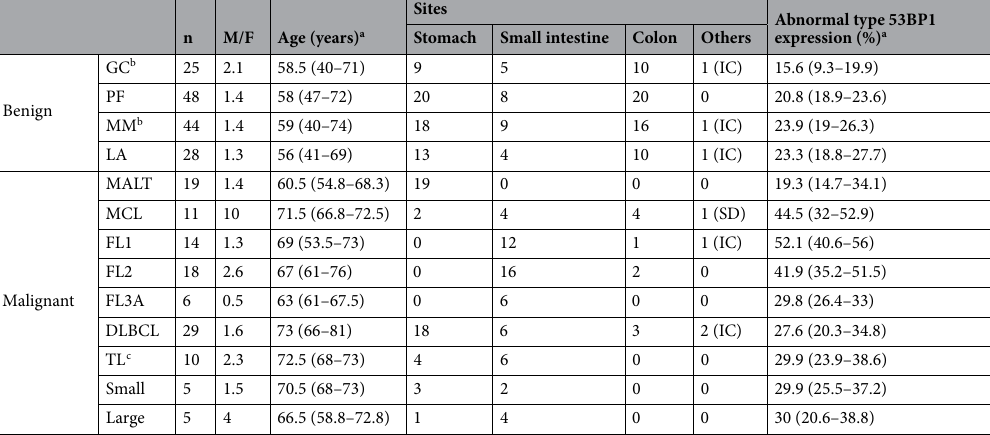
Table 1. Profiles of evaluated cases. M/F male/female, SD stomach and duodenum, IC ileocecum or Bauhin’s valve, GC germinal center, PF primary follicle, MM mantle-marginal zone, LA simple lymphoid accumulation, MALT mucosa-associated lymphoid tissue lymphoma, MCL mantle cell lymphoma, classical type, FL 1, 2, 3A follicular lymphoma grade 1, 2, 3A, DLBCL diffuse large B cell lymphoma, TL T cell lymphoma. a Median (interquartile range). b 23 cases were evaluated for both GC and MM. c TLs were subtyped by cell size: “small” consisted of small and medium cells , “large” consisted of large cells over than 70% (s mall cells : 1–2 × size of mature small lymphocyte, large cells : larger than 3 × size of mature small lymphocyte, medium cells : 2–3 × size of mature small